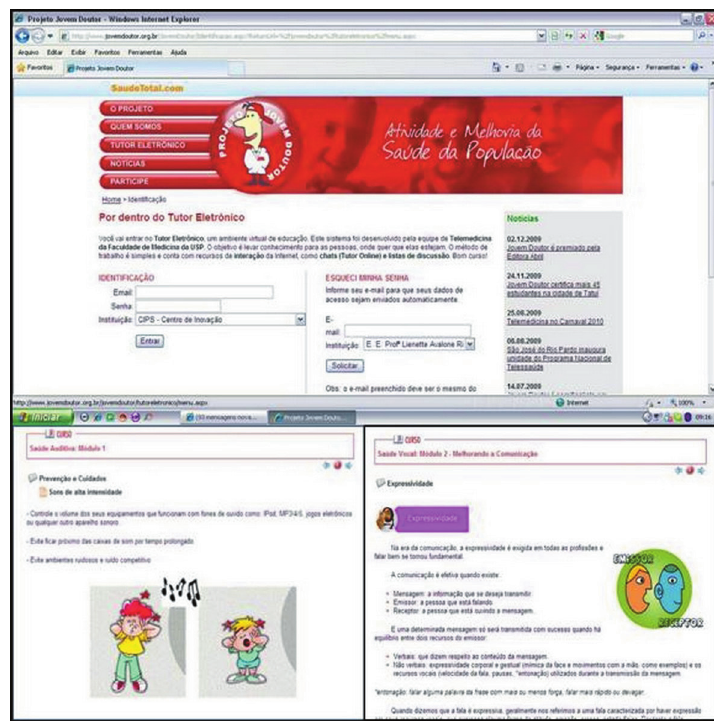
Figure 2- Virtual learning environment (Cybertutor) used in the Young Doctor Project